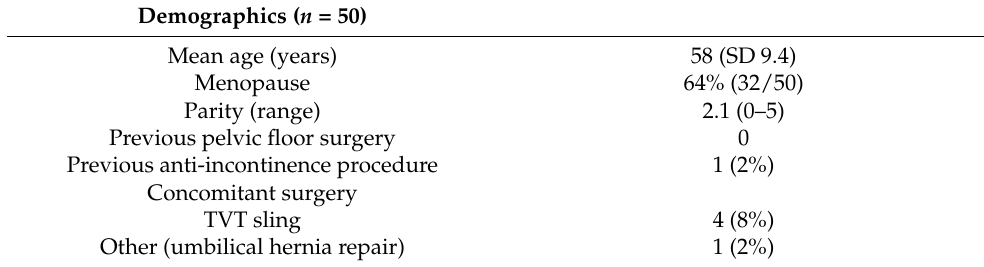
Table 1. Patient